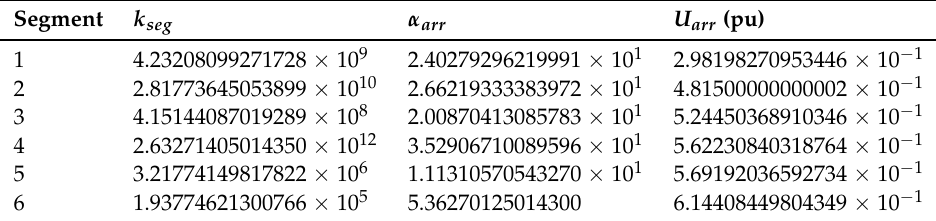
Table A2. EMTP-RV ZnO surge arrester V - I parameters, adopted from [19] (p.